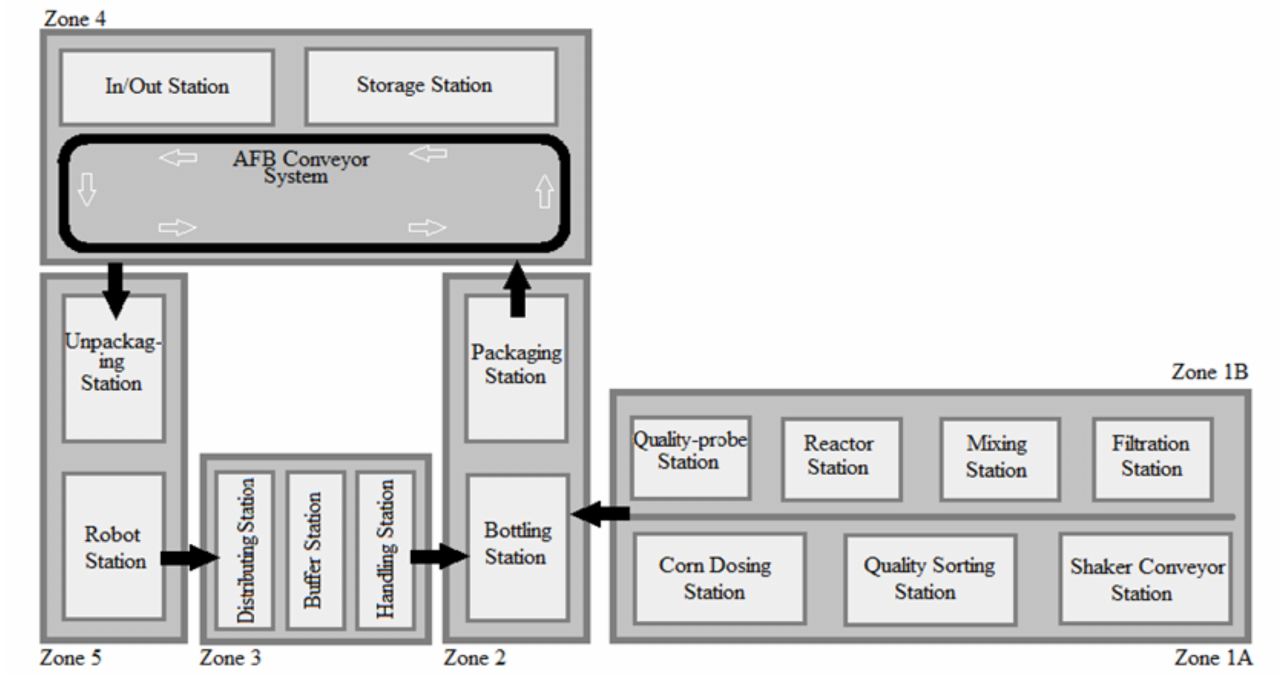
Figure 2. Model of production